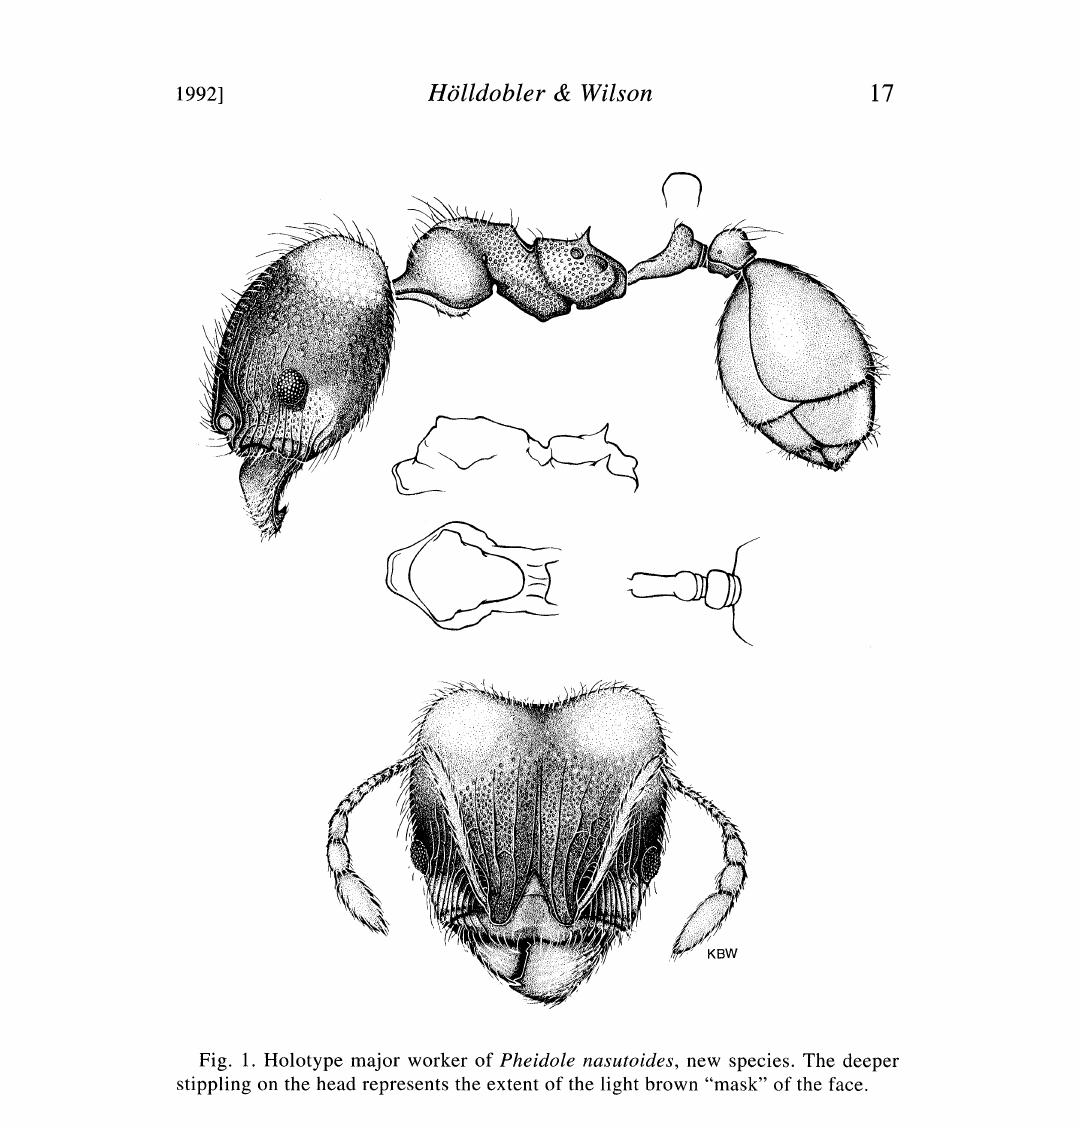
Fig. 1. Holotype major worker of Pheidole nasutoides, new species. The deeper stippling on the head represents the extent of the light brown "mask" of the face. 0.64 mm, Eye Length 0.16 mm, Pronotal Width 0.56 mm.